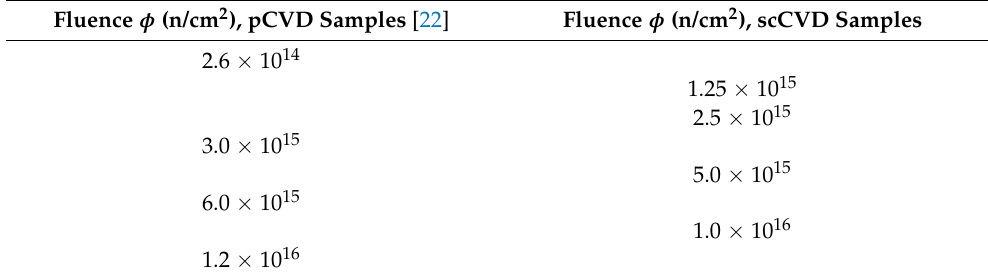
Table 1. Table of the irradiation fluences φ (n/cm 2 , 1 MeV equivalent). The new irradiations (scCVD samples) are indicated in the right column. Those carried out before this work [22] (pCVD samples) are on the